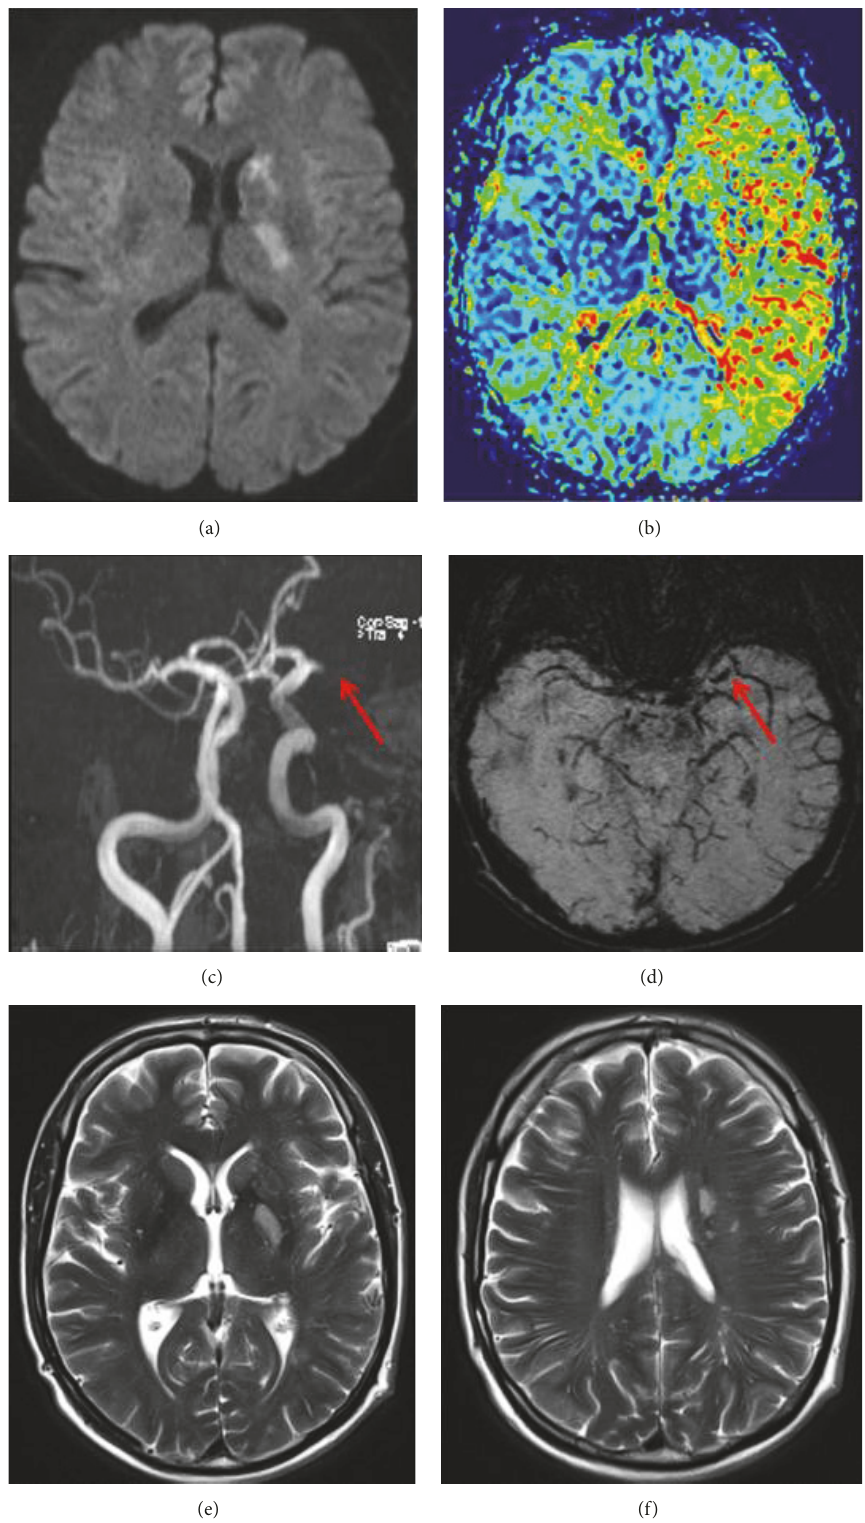
Figure 1: Cerebral magnetic resonance imaging 13 hours after stroke onset with a small diffusion lesion in the left basal ganglia and corona radiata with a complete perfusion deficit of the left MCA territory (a, b). Persistent occlusion of the MCA on magnetic resonance angiography ((c), red arrow) and susceptibility weighted imaging ((d), red arrow). T2 weighted imaging 24 hours after the intervention showing a small left sided basal ganglia infarction (e,